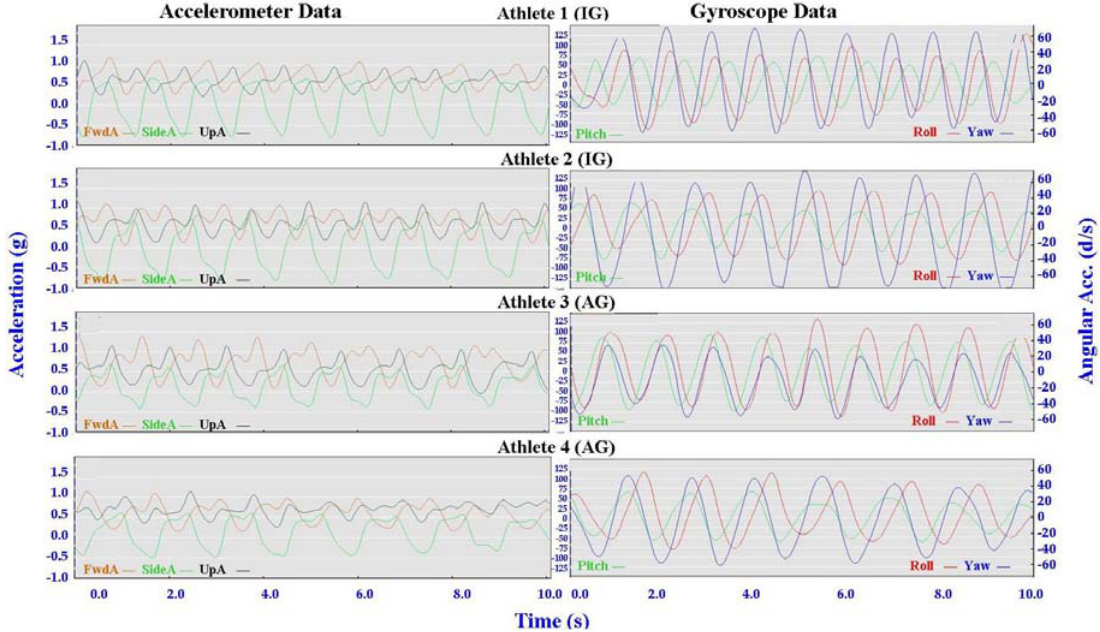
Figure 13. Comparison of Offset Skate (G2) gyroscope and accelerometer traces for four athletes (two from the IG and two from the